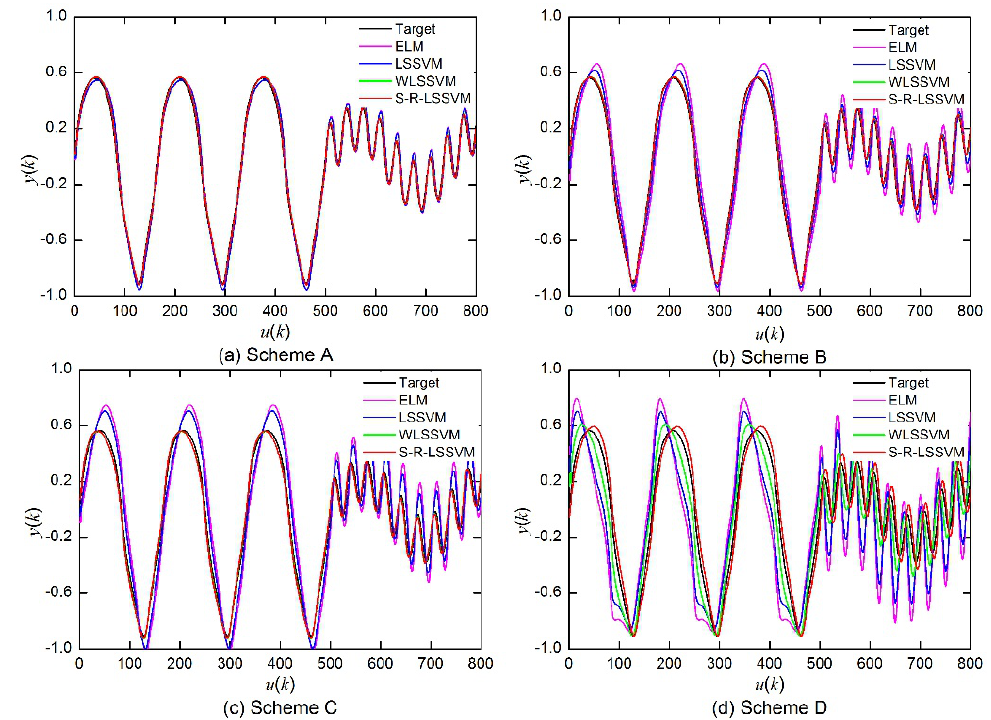
Figure 6. Prediction results of the nonlinear differential equation under the four schemes to add noises and outliers. Table 2. Comparison of the test results for the nonlinear differential equation.